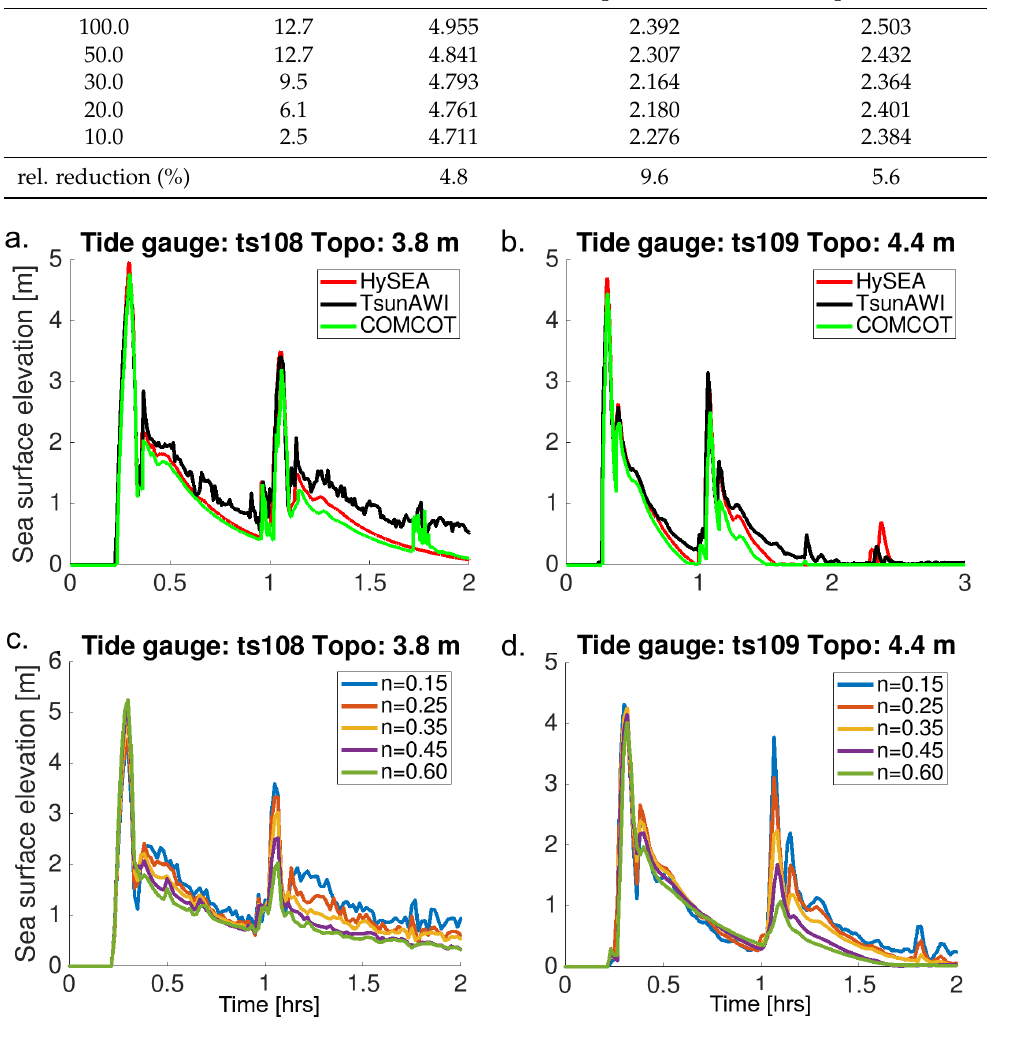
Figure 14. Upper panels: Numerical code comparison for Experiment 1730. Temporal evolution of the inundation process at two locations in Viña del Mar: ( a ). Virtual tide gauge “ts108” close to the coast. ( b ). Virtual tide gauge “ts109” about 500 m inland. Lower panels: Comparison of TsunAWI results for the full range of Manning values for Experiment 1730. Temporal evolution of the inundation process at two locations in Viña del Mar: ( c ). Virtual tide gauge “ts108”. ( d ). Virtual tide gauge “ts109” about 500 m inland. Refer to Figure 13 for their